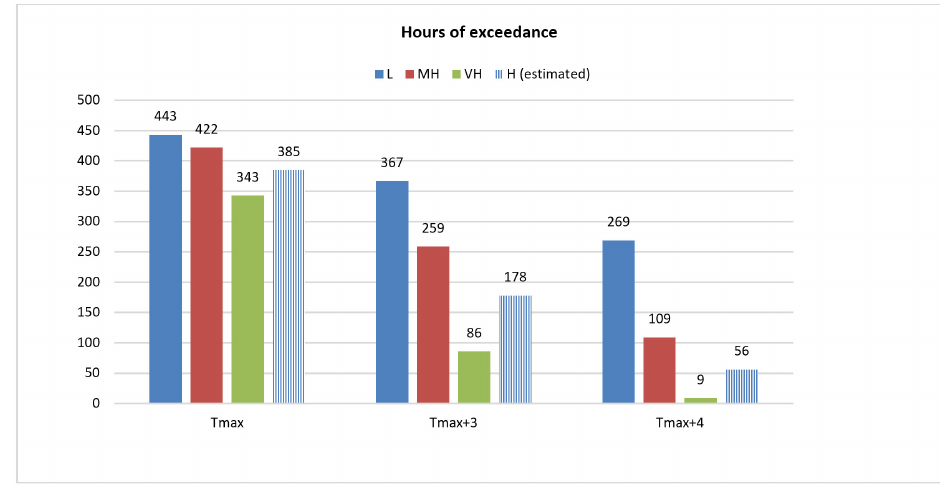
Figure 7. Hours of exceedance in all tested rooms during 1–30 June 2019, Hours 7:00–22:00.